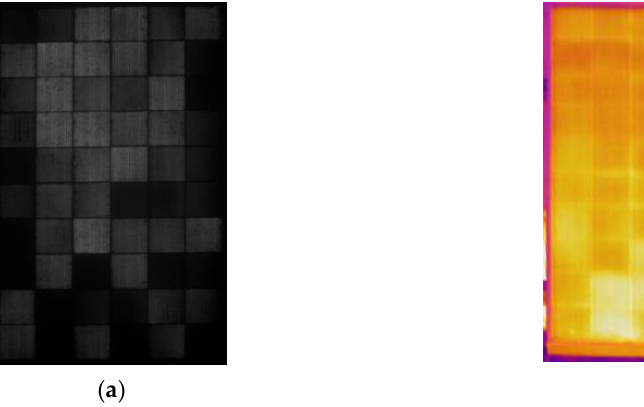
Figure 12. The typical electroluminescenceimage ( a ) and thermography image ( b ) of multicrystalline silicon solar module suffered from PID from the field.